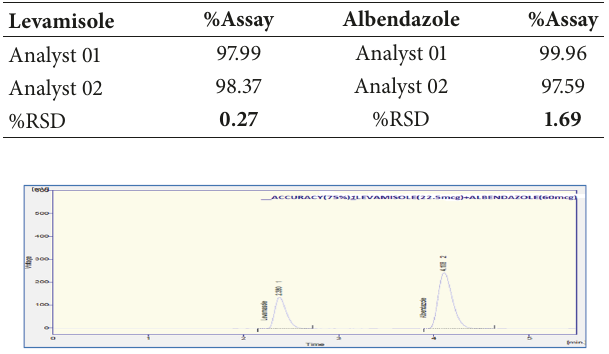
Table 6: Results for ruggedness.